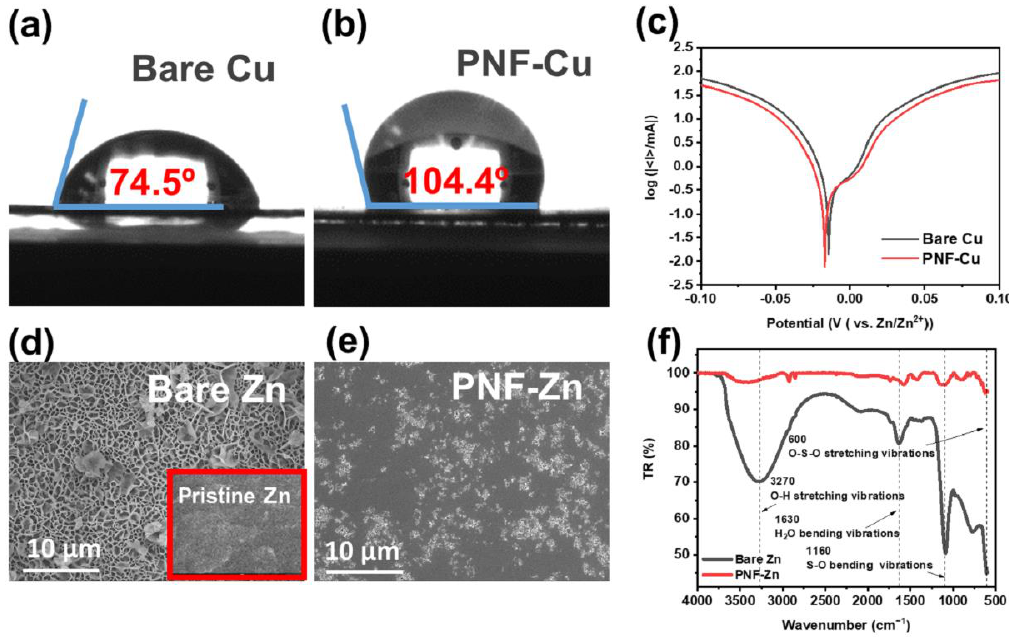
Figure 2. Contact angle measurement for aqueous solutions on ( a ) bare Cu and ( b ) PNF-Cu, ( c ) linear polarization curves showing the corrosion on bare Cu and PNF-Cu, and top-view SEM images of ( d ) bare Zn after immersion in the electrolyte for 7 days and pristine Zn (inset), ( e ) PNF-Zn after immersion in the electrolyte for 7 days, and ( f ) FTIR spectra of the bare Zn and PNF-Zn after immersion in the electrolyte for 7 days.